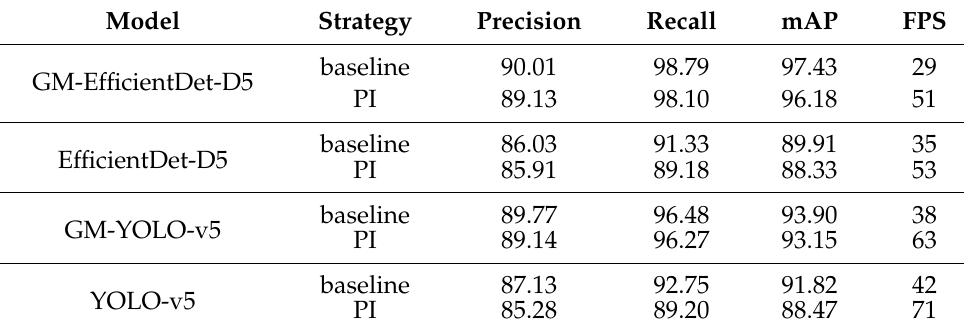
Table 7. Performance of different pruning strategy on different